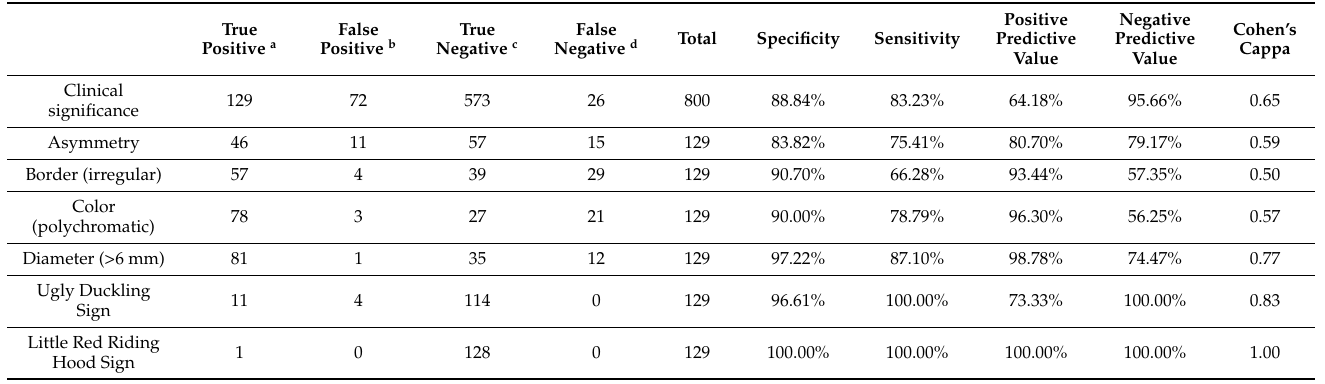
Table 1. Results of the macroscopic assessment by the expert and the non-specialist.